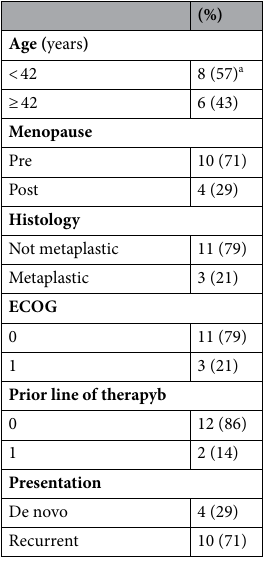
Table 1. Patients characteristics. a Percentage of cases. b In the metastatic